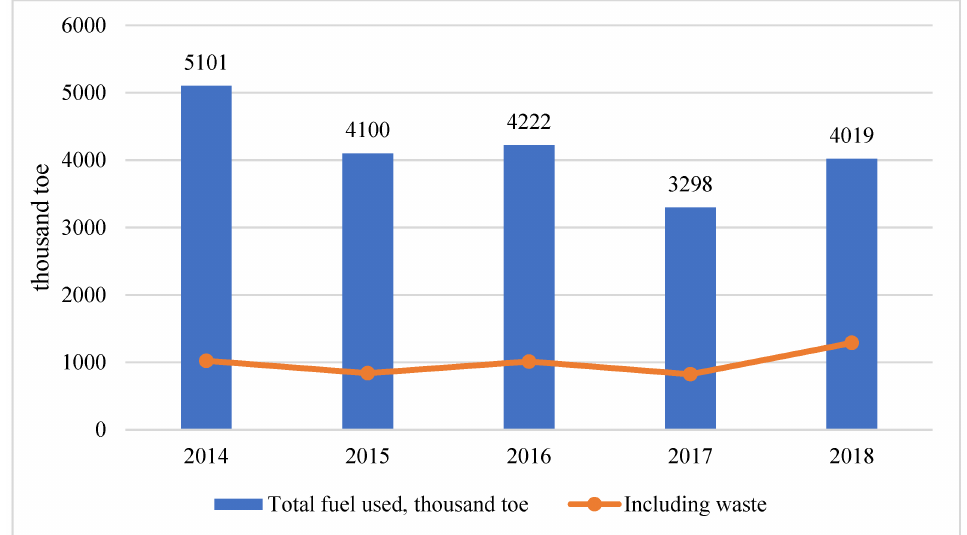
Figure 6. The total amount of fuel used in the Kyiv region (thousand toe). Source: own calculations based on statistics from